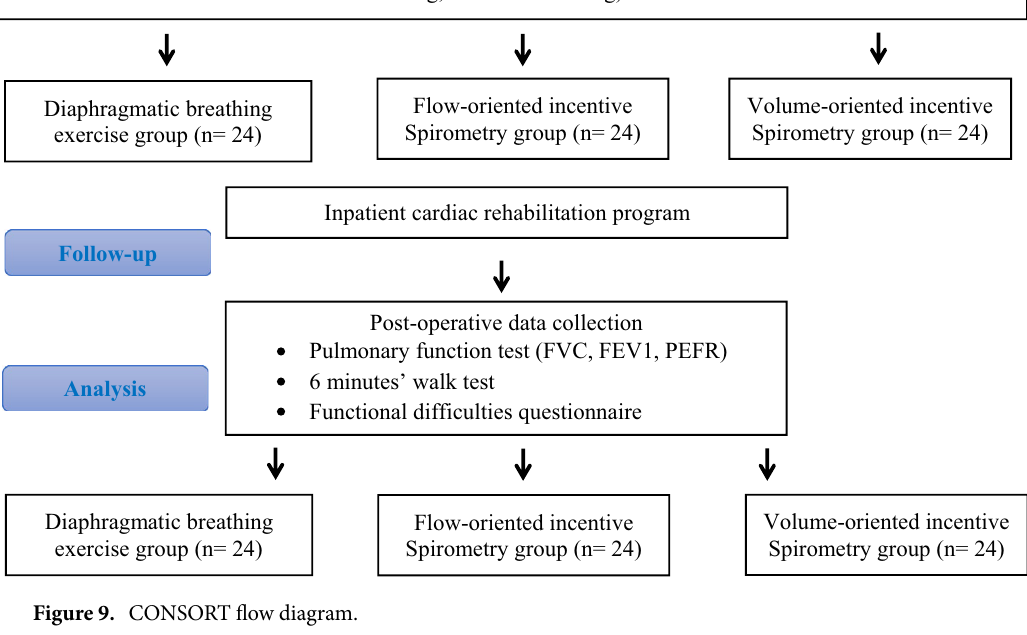
Figure 9. CONSORT flow